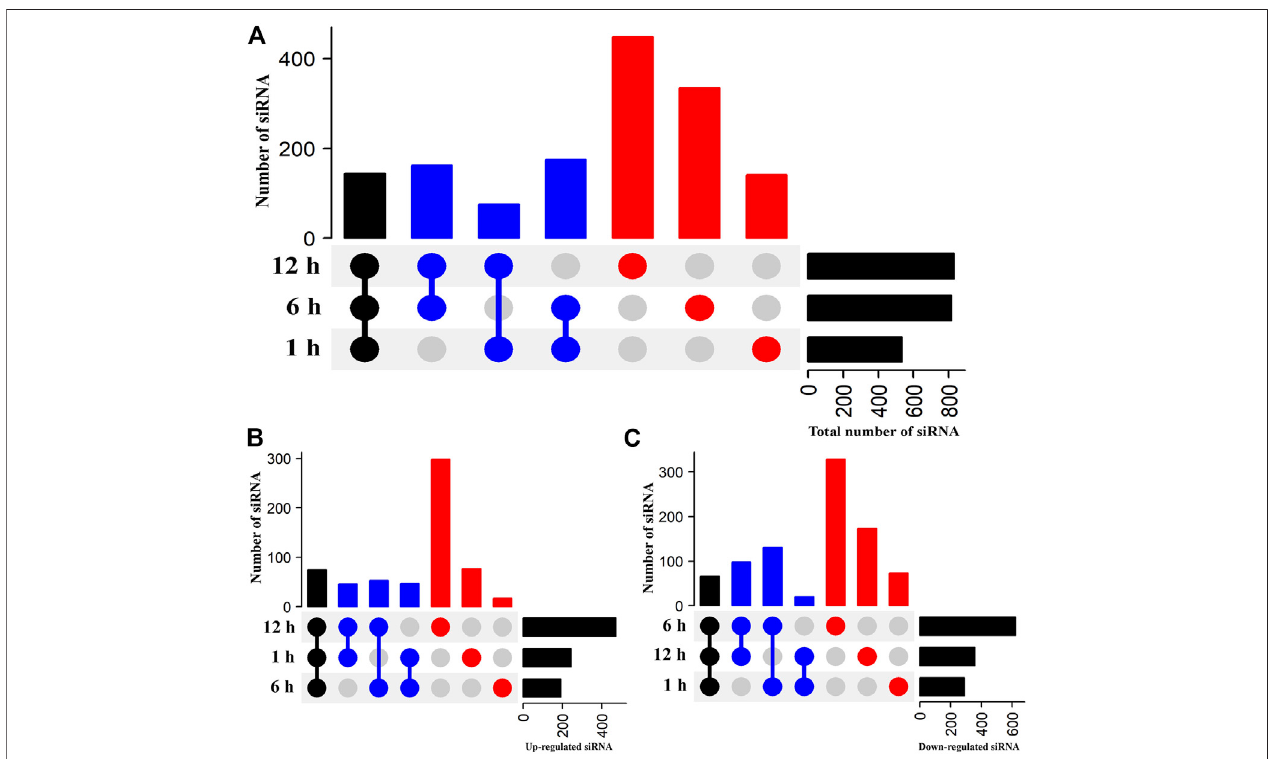
FIGURE 3 | Heat-stress responsive DE-siRNAs in fl owering Chinese cabbage. UpSetR plots represent DE-siRNAs after 1, 6, and 12 h of heat stress, relative to control (0 h). Black vertical bars highlight common DE-siRNAs at all three time points, blue vertical bars represent common DE-siRNAs at two time points (e.g., 1 and 6 h),and redverticalbars representDE-siRNAs atonetimepoint. Horizontalblack barsindicate totalnumber ofDE-siRNAs atindividual time points. (A) Totalnumberof DE-siRNAs, (B) upregulated DE-siRNAs, and (C) downregulated DE-siRNAs in fl owering Chinese cabbage after 1, 6, and 12 h of heat stress.